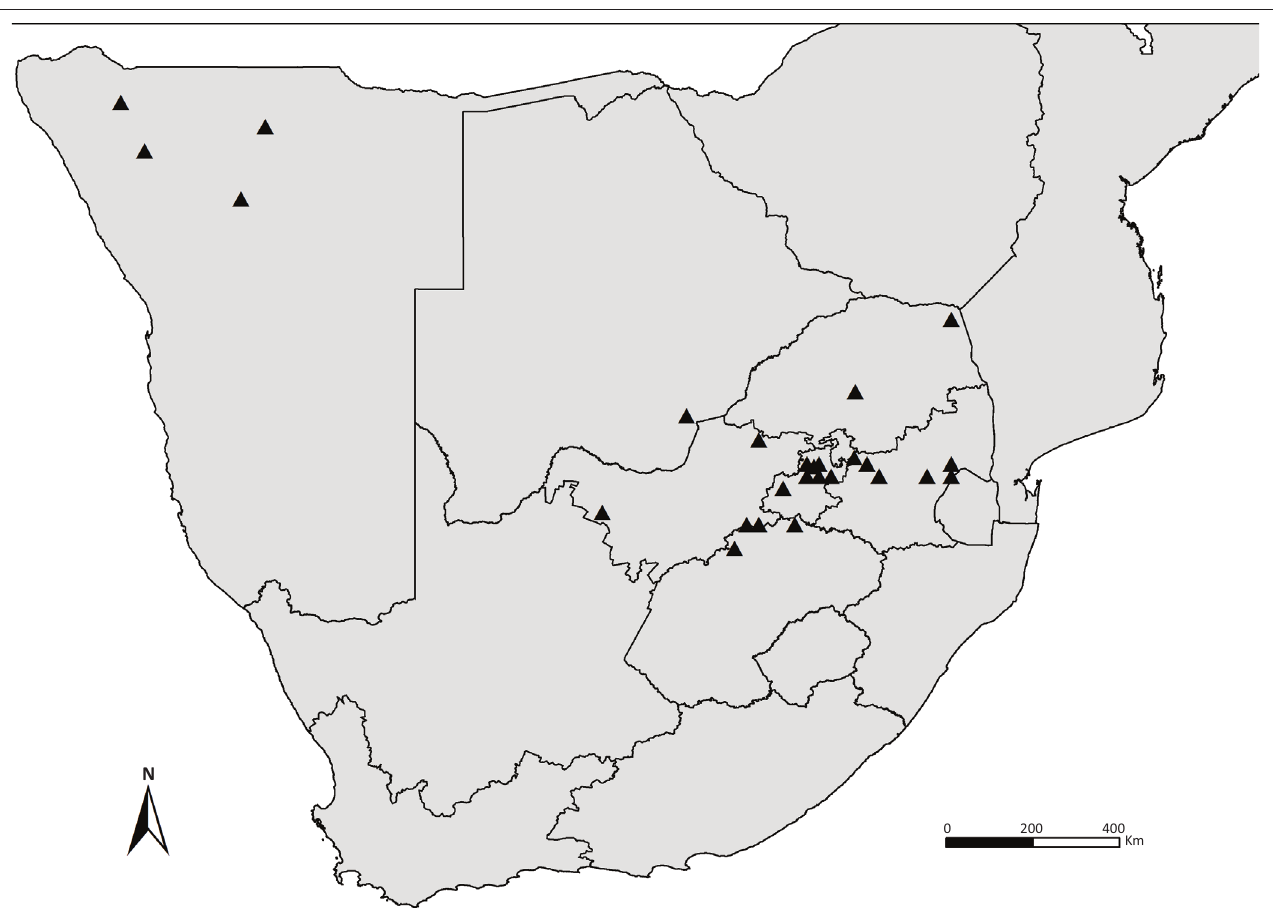
FIGURE 5: Geographical distribution of N. ficifolia in southern